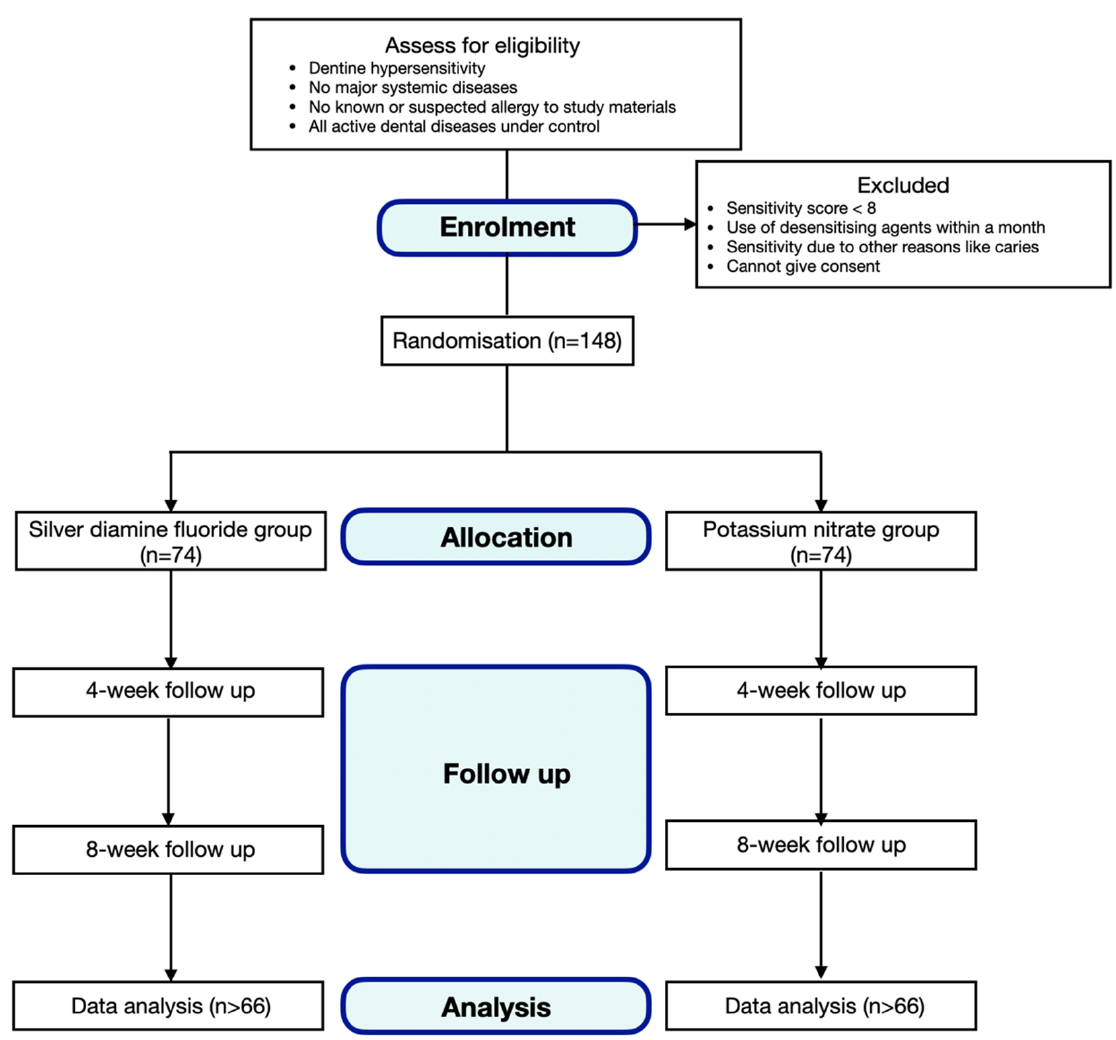
Figure 2. Consort flow diagram.